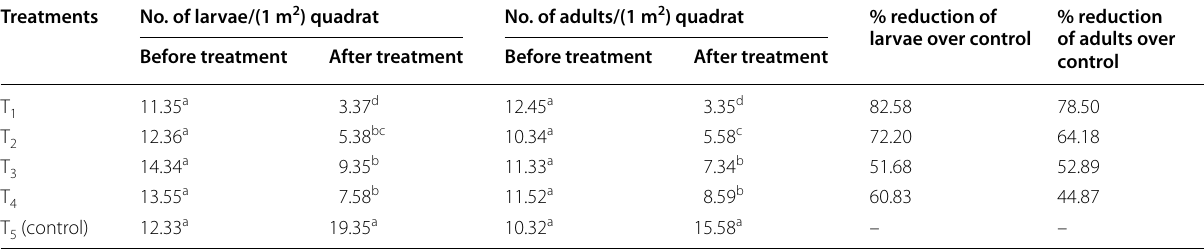
Table 4 Efficacy of different pest management modules in controlling hog-plum beetle, P. 14-punctata under field condition during 2018